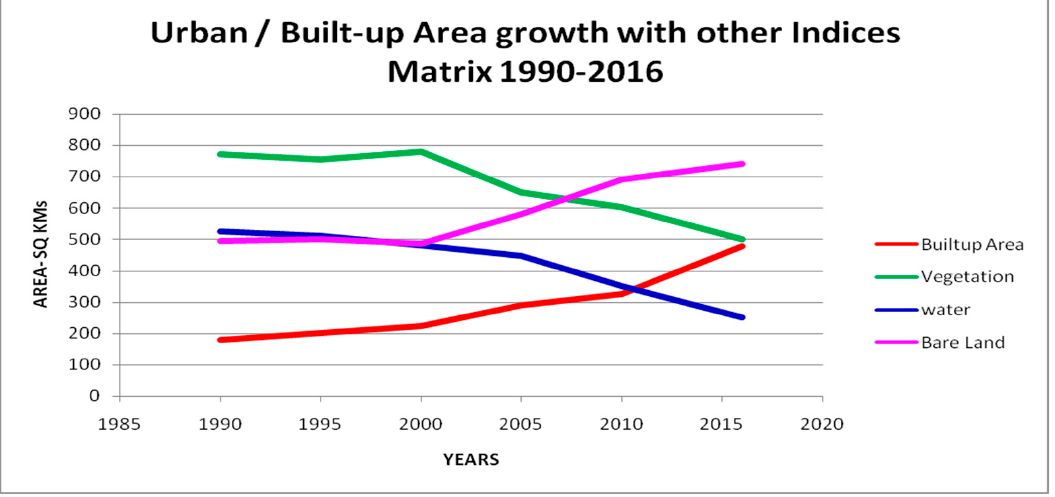
Figure 6. Urban sprawl 1990–2016 graphical representation.